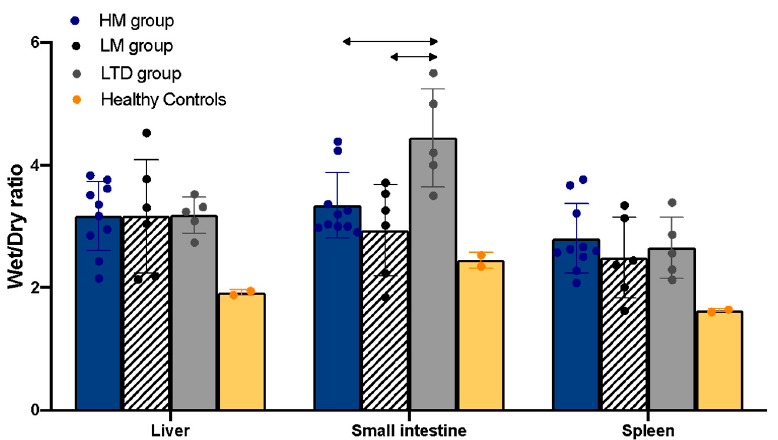
Figure 4. Wet–dry ratio represented in the abdominal organs per group. The data are presented as mean and standard deviation, and as individual values (scattered dots). The arrows represent statistically significant difference between groups.